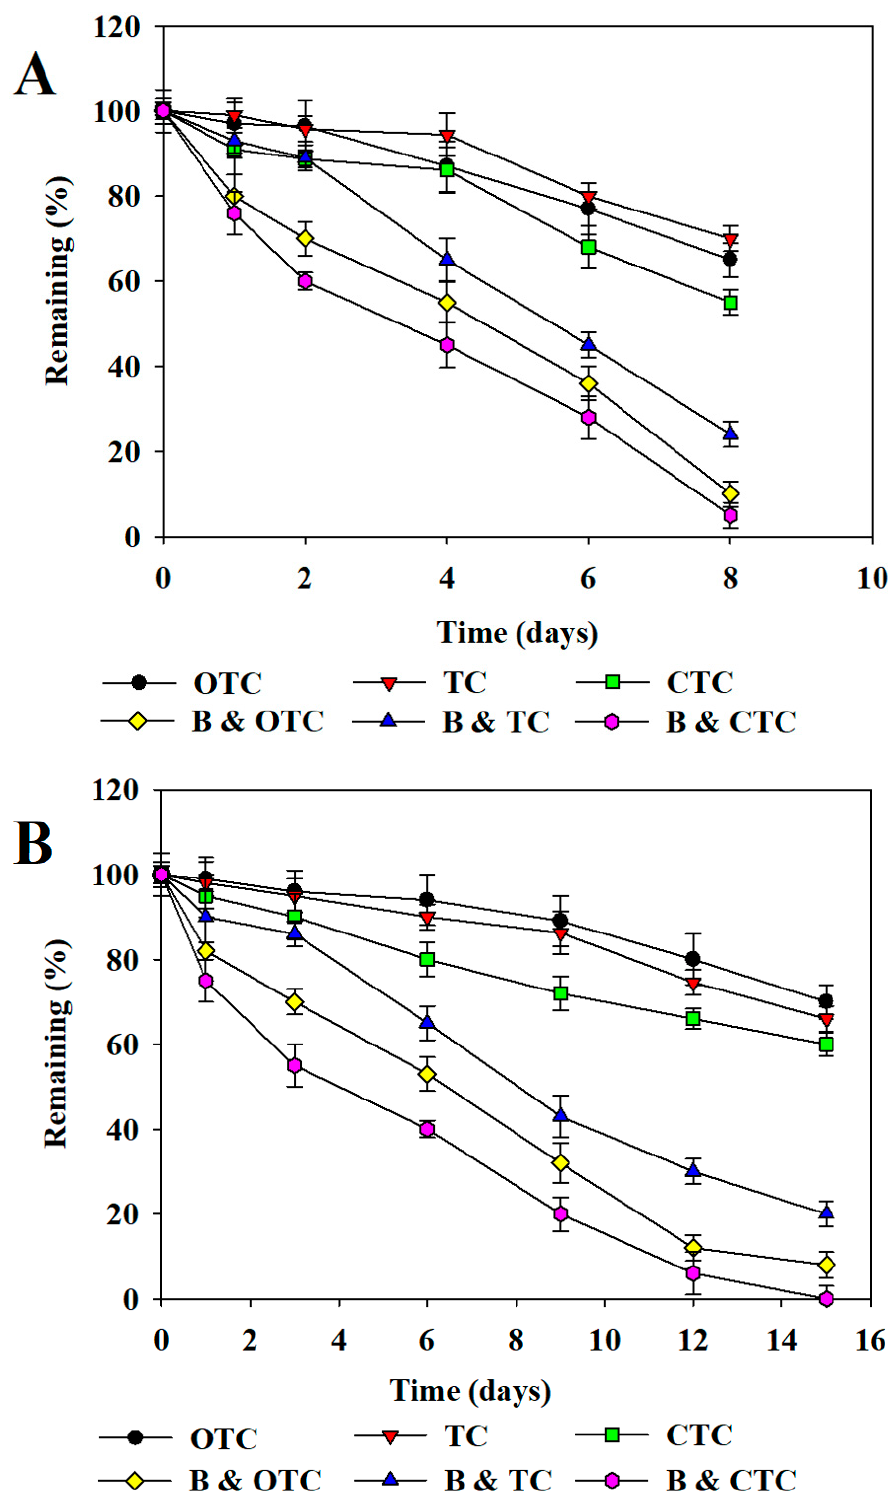
Figure 3. Degradation of tetracyclines with and without degrading bacteria in sludge. Aerobic ( A ) and anaerobic ( B ) degradation of TCs. TC: tetracycline, CTC: chlortetracycline, OTC: oxytetracycline. B: isolated antibiotic-degrading bacteria. Data from three independent experiments are presented as the means ± SE.